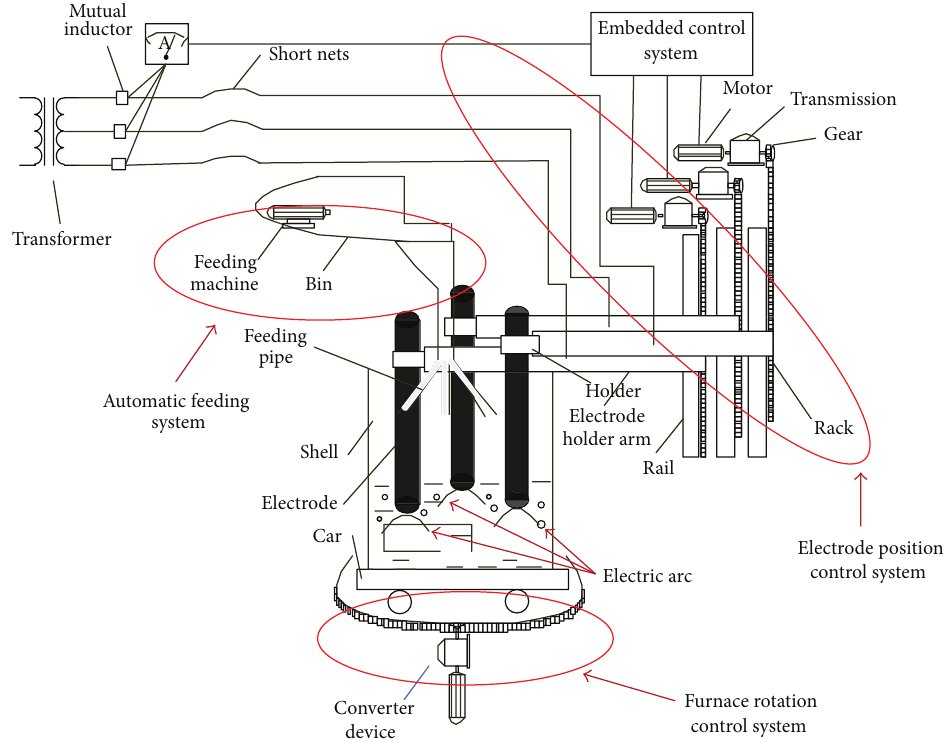
Figure 1: Sketch map of arm-type electro-fused magnesia